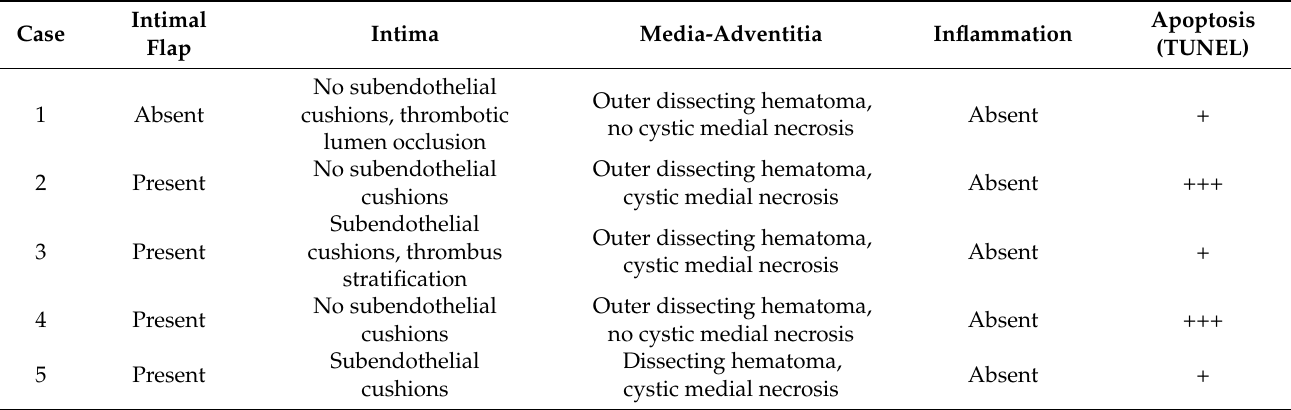
Table 3. Microscopic features of the ductus